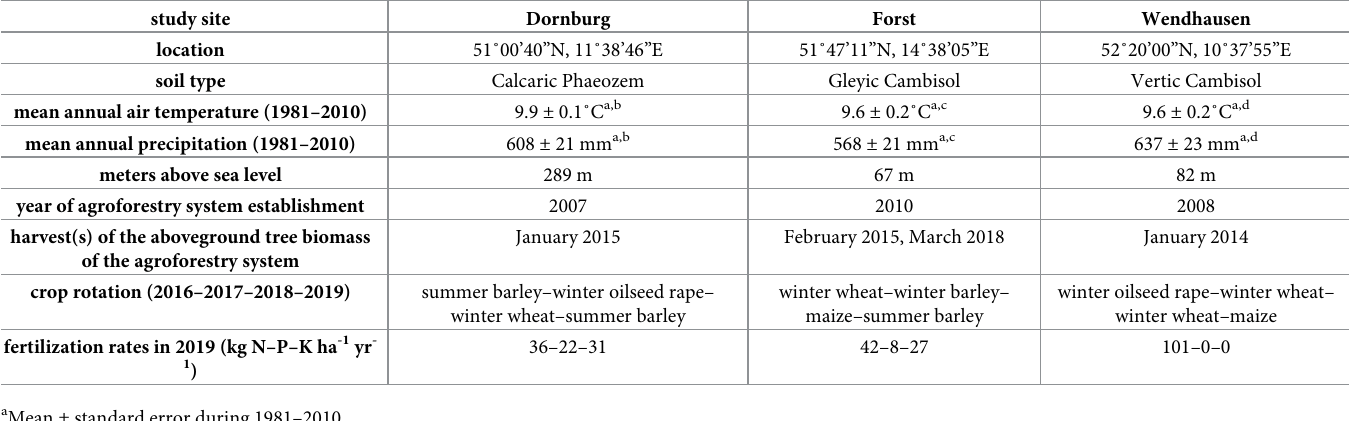
Table 1. Site characteristics and management at the three study sites of paired temperate agroforestry and monoculture cropland. study